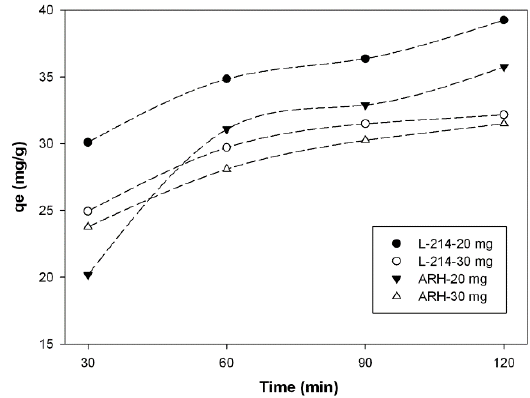
Figure 9. Gold adsorption capacity (mg/g) as a function of contact time by the ARH and L-214 (25 °C, 100 rpm, pH = 0.51, and 10 mL waste Table 4. Thermodynamic constants for the adsorption of gold ions at various temperatures. ARH L-214 Thermodynamic constants